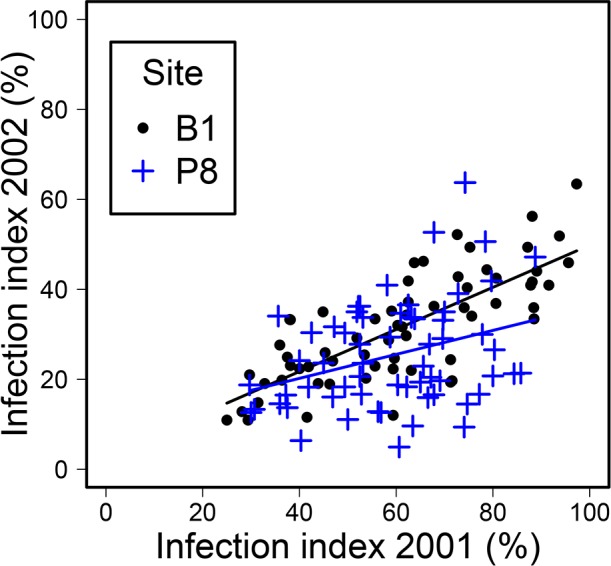
Infection severity in 2002, as a function of severity in 2001, at the two sites.